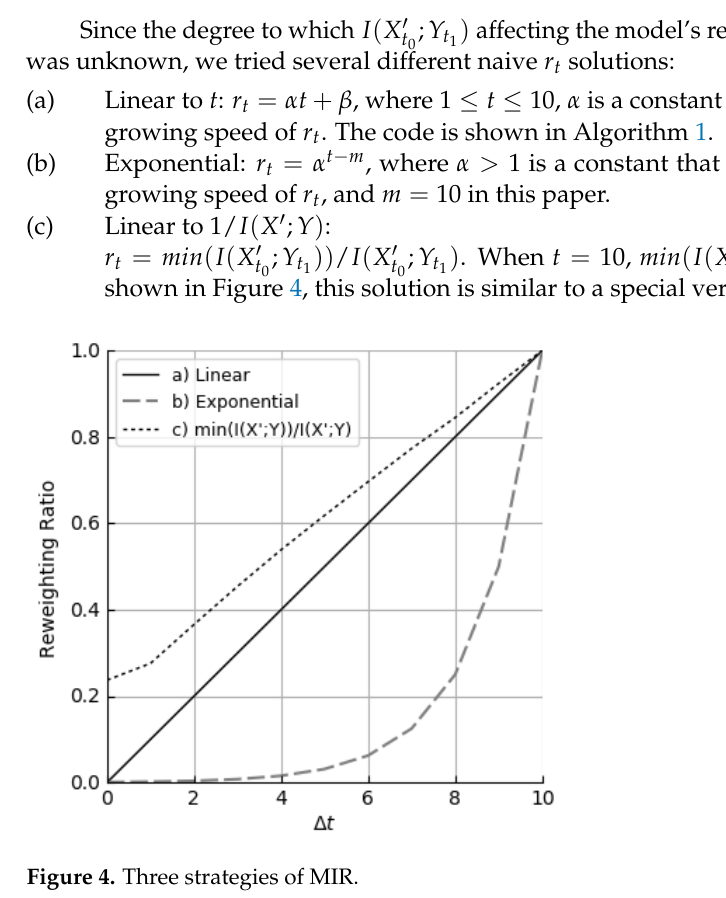
Figure 4. Three strategies of